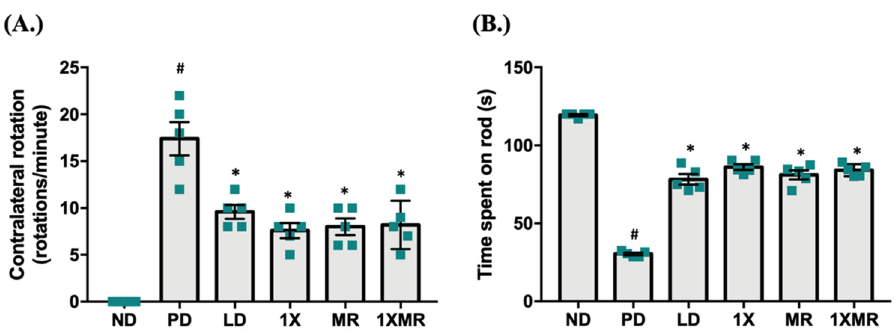
Figure 1. Evaluation of motor function in the ND, PD, LD, 1X, MR, and 1XMR groups after 8 weeks of treatment. ( A ) Contralateral rotations during the apomorphine-induced rotation test. ( B ) Endurance performance in the rotarod test. Data are expressed as mean ± SEM ( n = 5 rats/group). Significant differences (bars) are expressed as p < 0.05. One-way ANOVA with Tukey’s post hoc test; # p < 0.05 for comparison of the PD group with the ND group; * p < 0.05 for comparison of LD, 1X, MR, and 1XMR groups with the PD group. ND, non-diseased; PD, untreated PD; LD, PD treated with 8 mg of L-DOPA; 1X, PD supplemented with the probiotic; MR, PD supplemented with MR as prebiotic; 1XMR, PD supplemented with a combination of 1X and MR.